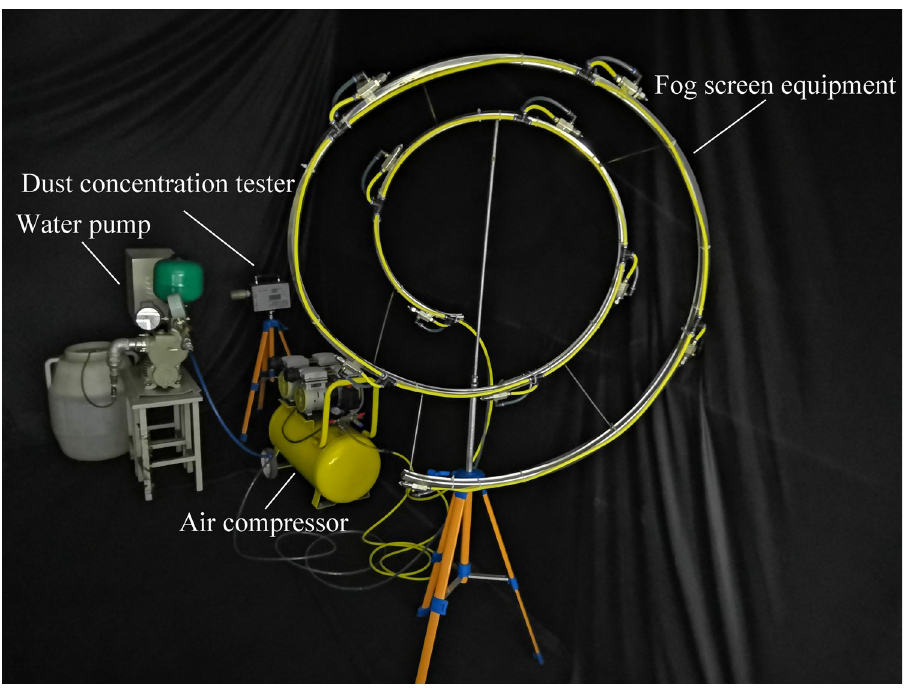
Fig 12. Layout of a similar test